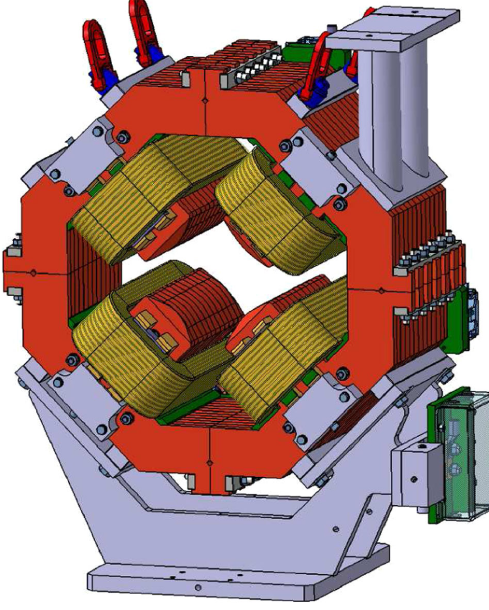
FIG. 10. Sketch of quadrupole magnet.